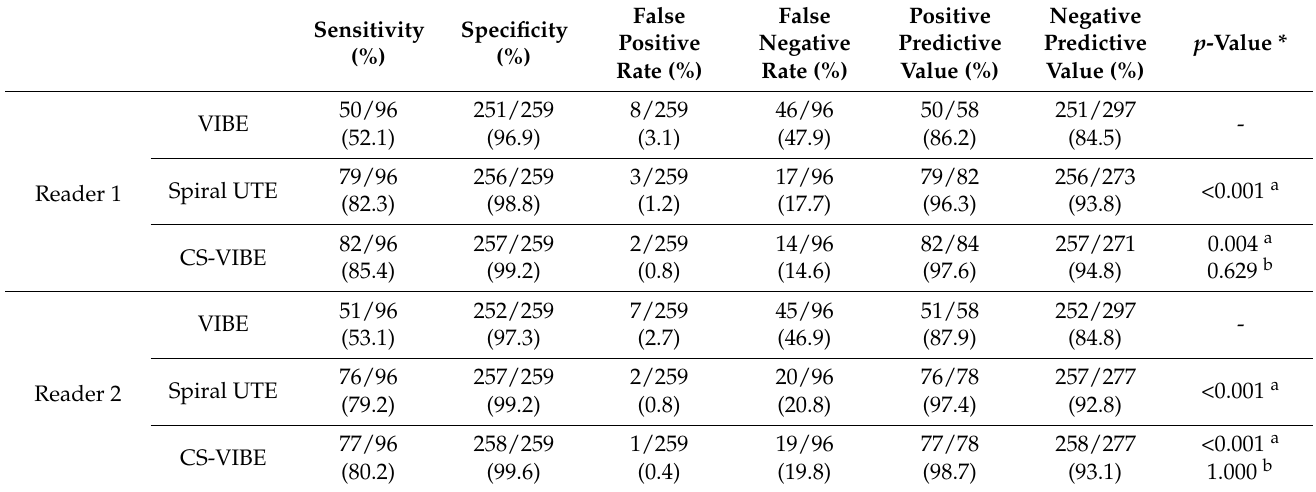
Table 4. Assessment of nodule detection capability of lung MR images.